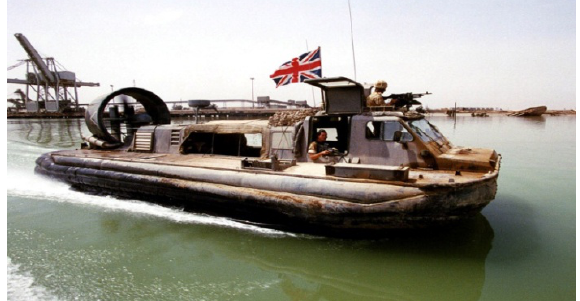
Figure 11 – USA hovercraft